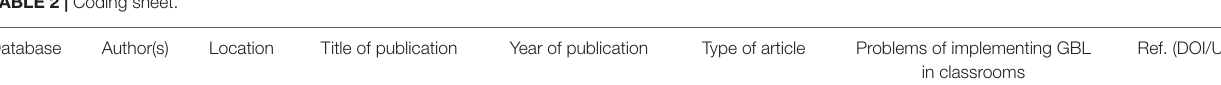
FIGURE 1 | Review process. TABLE 2 | Coding